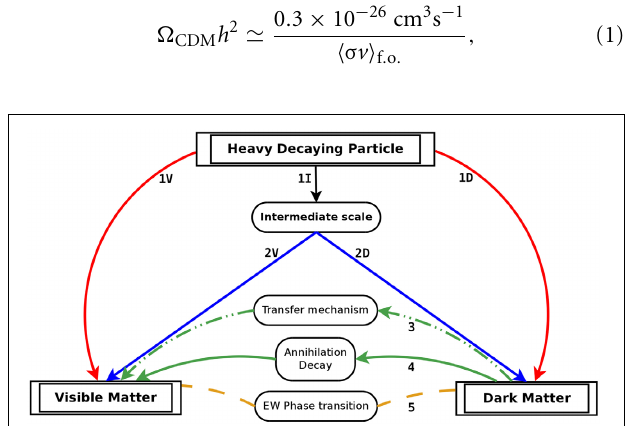
FIGURE 1 | A schematic of the different mechanisms relating DM to baryon asymmetry. The lines are the different stages of the considered mechanism. The labels on the lines are used to describe the model.